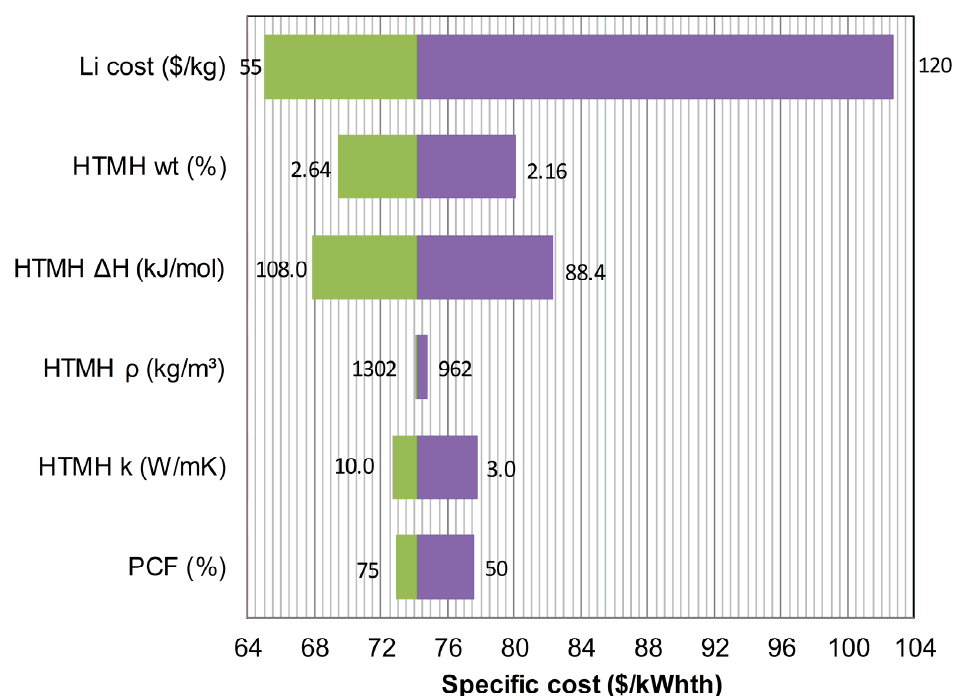
Figure 6. LiAl-TiFe system tornado sensitivity chart with the baseline specific cost (74.2 $/kWhth) achieved at: Li raw cost = 70 $/kg, HTMH wt = 2.4%, HTMH Δ H = 98.2 kJ/mol H2 , HTMH ρ = 1132 kg/m 3 , HTMH k = 6 W/mK, PCF = 63%.